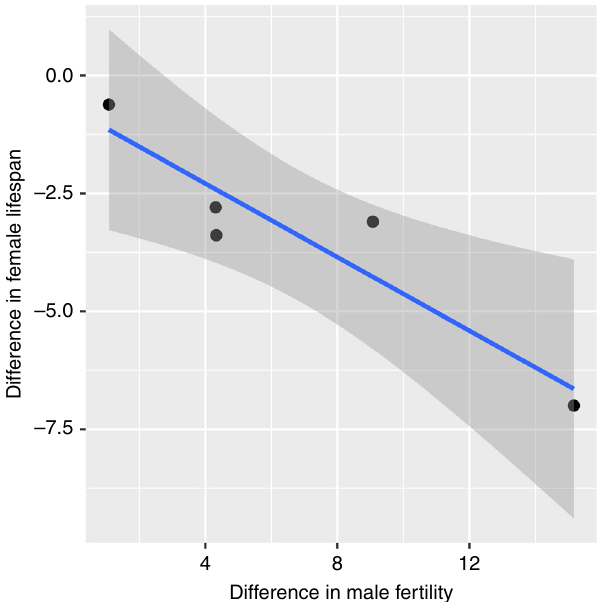
Fig. 2 Detrimental effect of selection for late-life male fertility on female longevity ( = net health). Changes in female lifespan were regressed against improvements in male fertility in populations subject to arti fi cial selection for male late-life fertility relative to the stock population from which experimental fl ies were derived (correlation coef fi cient = − 0.93; P = 0.022). Thus the stock population acts as a baseline against which evolution was assessed. If a value is equal to zero, the trait average in the selected population is identical to the trait average in the control population. As the value increases, the experimental population has an increasingly higher trait value relative to the control population. As the value declines, the experimental population has a lower trait value than the control. Line averages and 95% con fi dence intervals are shown